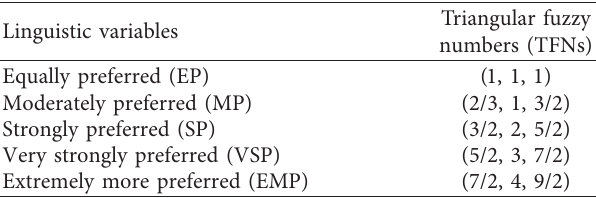
Table 1: Linguistic variables and TFNs for the evaluation of criteria. Linguistic